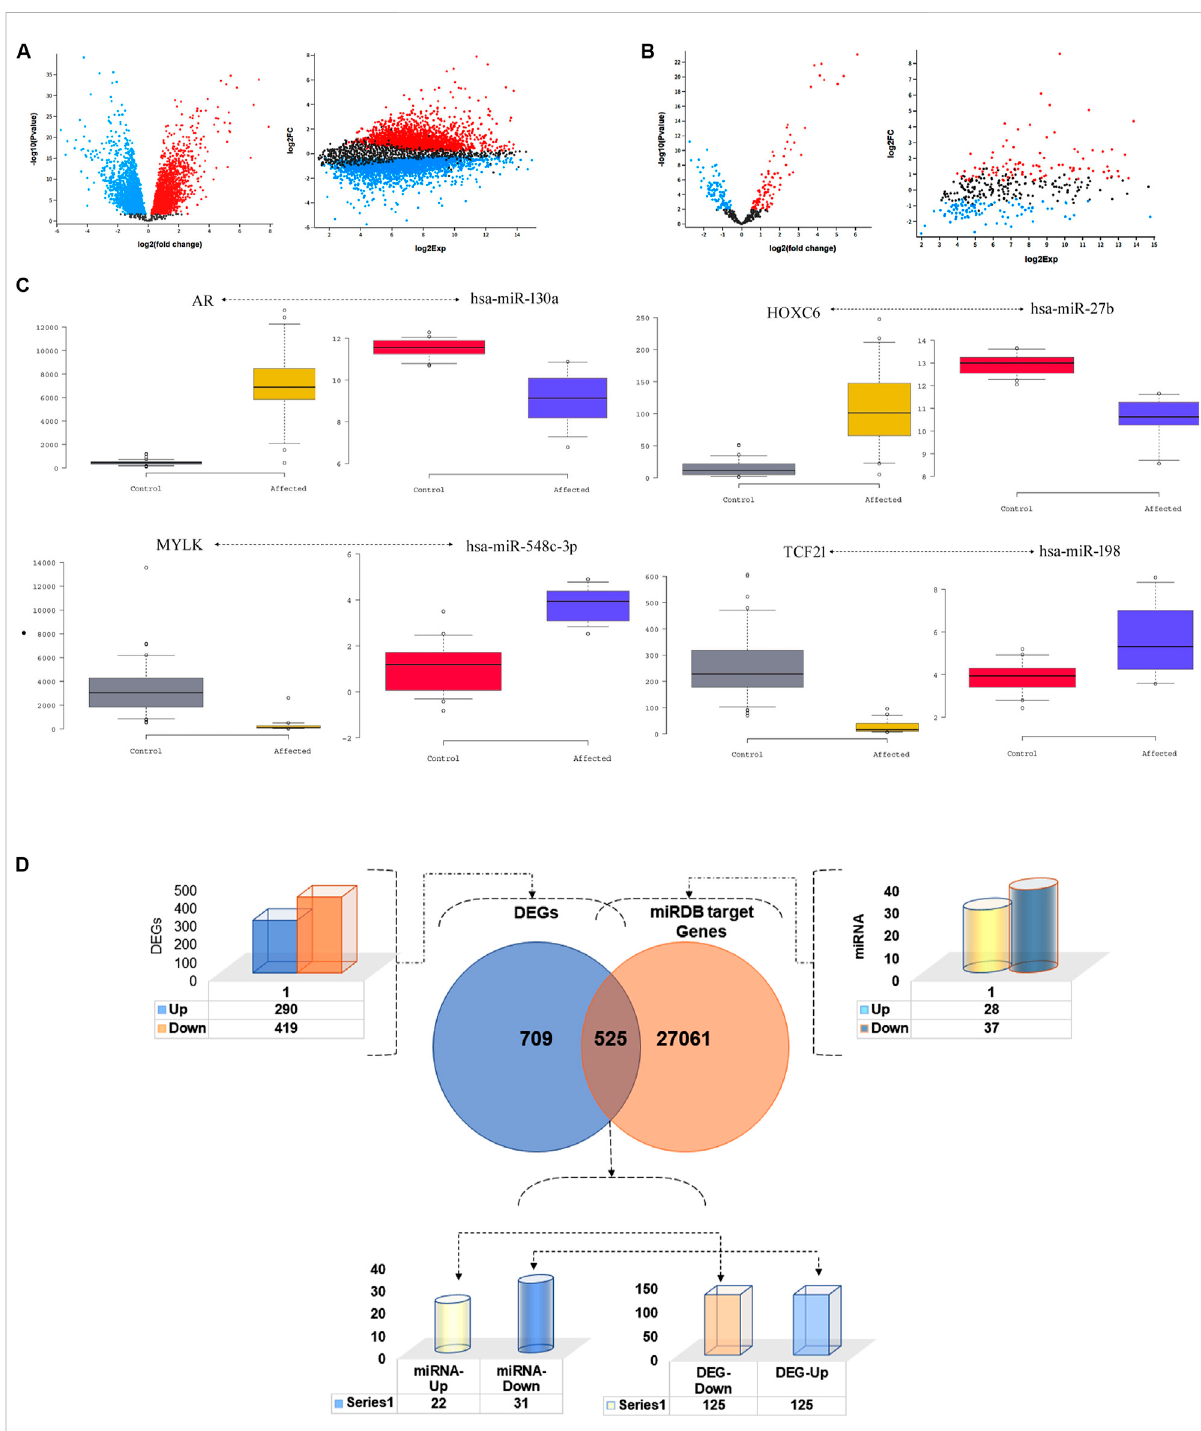
FIGURE 2 Distribution of differentially expressed genes and miRNAs. Volcano plots of (A) GSE6919 and (B) GSE21036 datasets showing the transcript expression pro fi les mRNA and miRNA respectively, of metastatic prostate cancer and normal prostate tissues. Red and blue dots correspond to the up and down regulated genes, respectively, showing more than 1.5-fold expression difference ( p < 0.05). (C) Wesker Box plot of inverse co-related miRNA and their target DEGs (D) . DEGs and miRNA target gene fi ltration